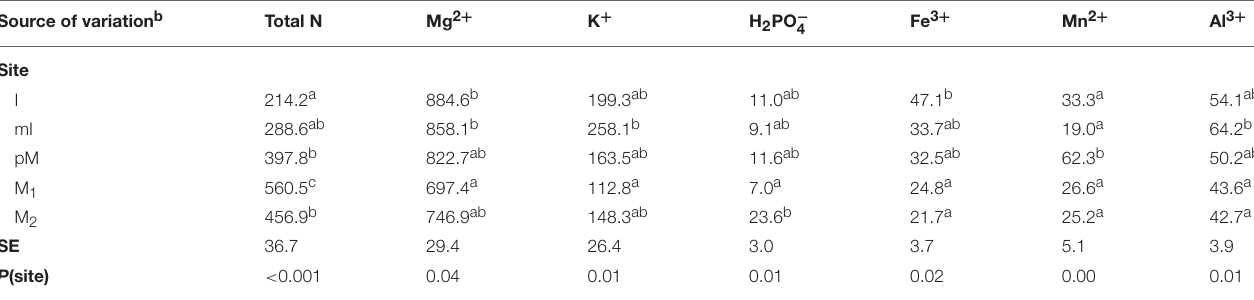
TABLE 3 | Soil nutrient supply rates ( µ g ion/PRS ® Probe/3 week) in the experimental pots across forest site treatments. Source of variation b